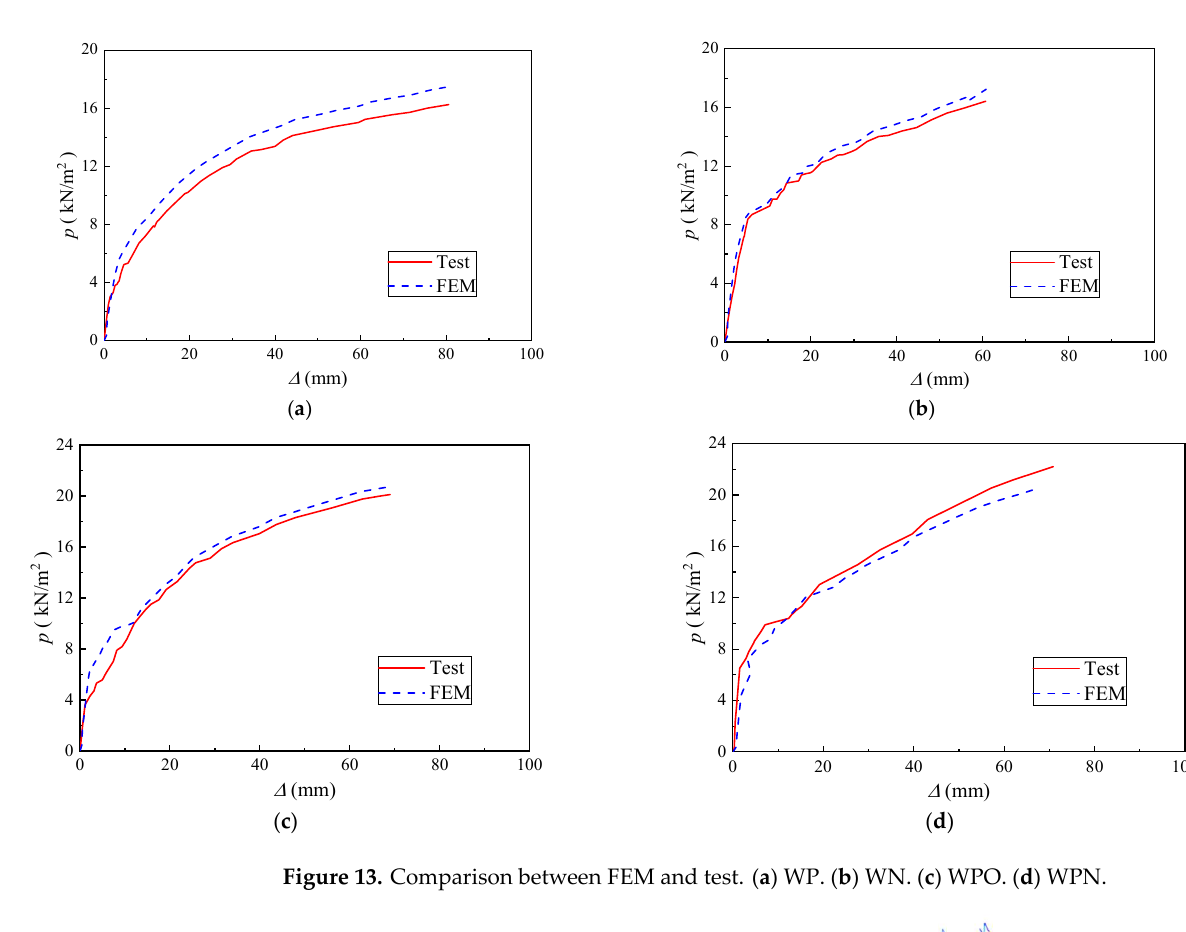
( b ) Figure 12. Finite element model of sandwich wall with reasonable mesh sizes. ( a ) Concrete layer. ( b ) Reinforcements.